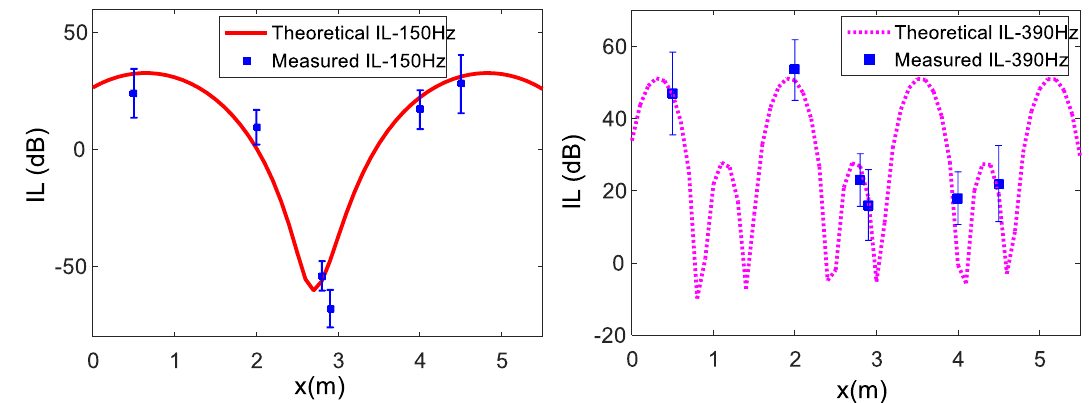
Figure 16. Optimization of installation position of RSHPA (150 Hz and 390 Hz).